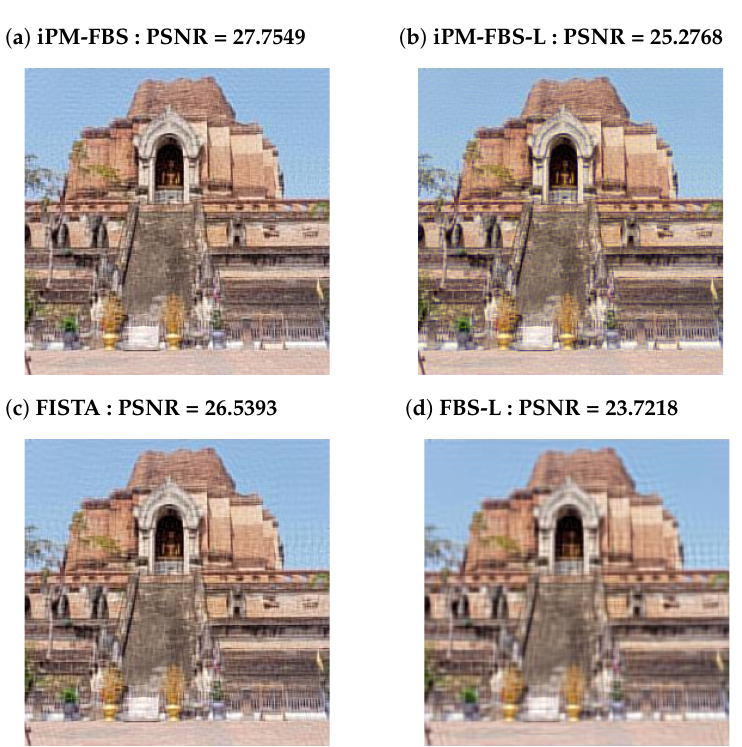
Figure 3. The images recovered in scenario I in the case of τ = 10 − 8 . ( a – d ) Images recovered using iPM-FBS, iPM-FBS-L, FISTA, and FBS-L, respectively.